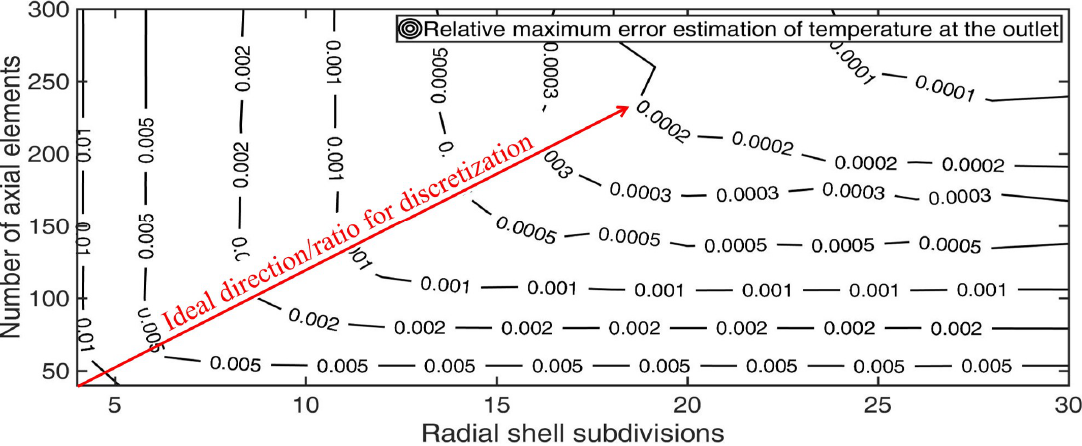
Figure 16. Estimations of maximal absolute errors at the outlet of the pipe (Case 1), where the red arrow signifies the ideal direction for discretization.